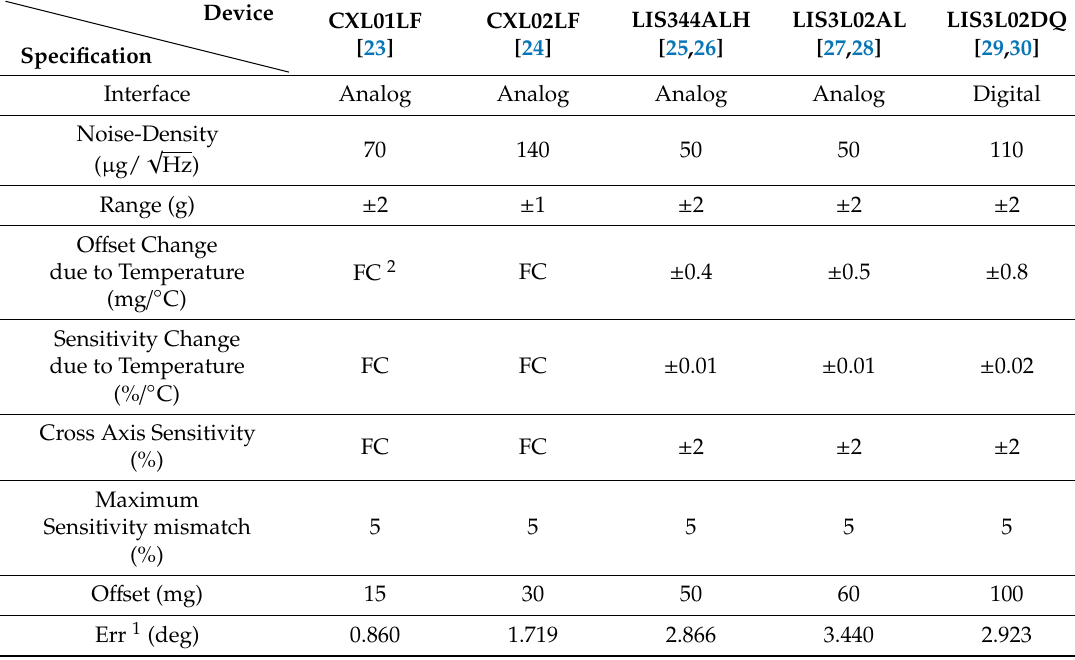
Table 1. Micro-electro-mechanical system (MEMS) accelerometers used in civil engineering [22]. Device CXL01LF LIS344ALH CXL02LF [23] [24] Specification Interface Analog Analog Analog Analog Digital